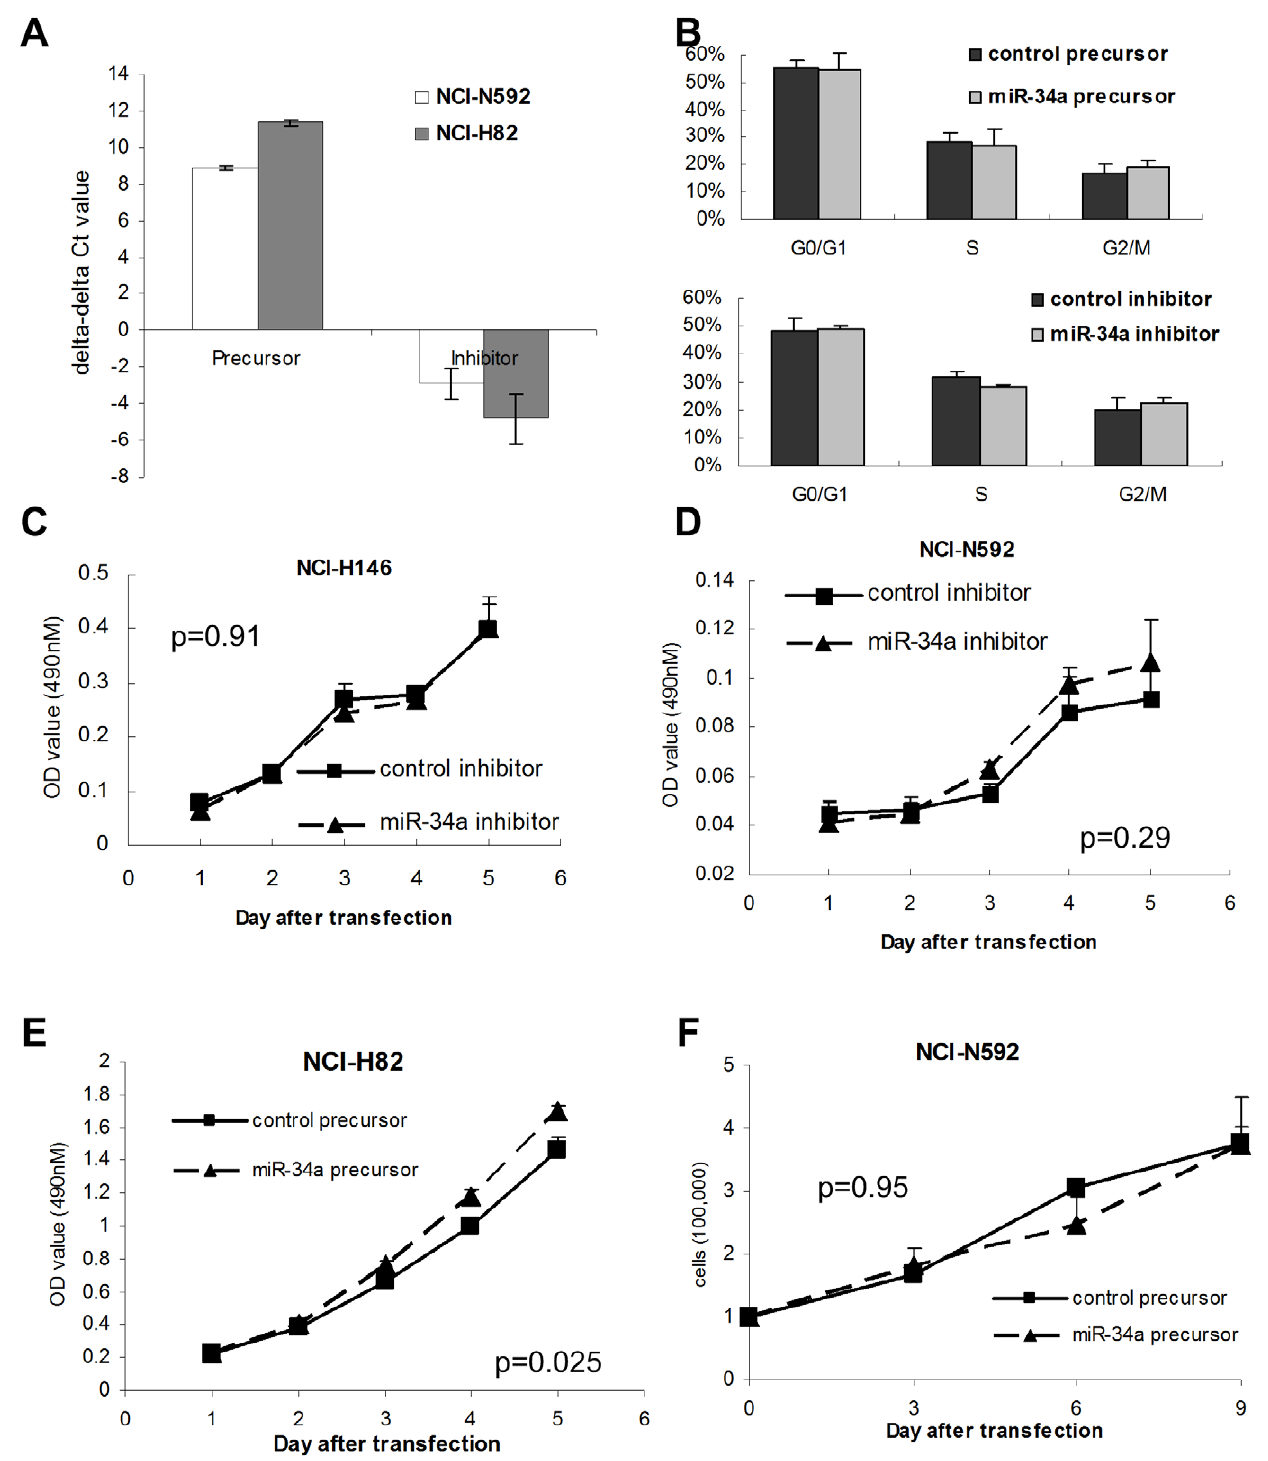
Figure 1. Ectopic overexpression or downregulation of miR34a in SCLC cell lines by microRNA precursor or inhibitor. (A) miR-34a expression in NCI-N592 cells and NCI-H82 cells transfected with miR-34a precursor or inhibitor. The delta-delta Ct value was calibrated to the delta Ct value of miR34a in cells transfected with control miR precursor or inhibitor, respectively. (B) Cell cycle distribution of NCI-H82 cell transfected with control miR precursor, miR-34a precursor, control miR inhibitor, and miR-34a inhibitor. (C and D) Cell growth assay of NCI-H146 (C) and NCI-N592 (D) cells transfected with miR-34a inhibitor or control miR inhibitor. (E) Cell growth assay of NCI-H82 cells transfected with miR-34a precursor or control miR precursor. (F) Cell viability of NCI-N592 cells after repetitive transfection of control miR precursor or miR-34a precursor. Cells were counted and transfected again every three days. Error bars indicate standard deviation. p-values were calculated according to cell viability 5 days after transfection with the exception of microRNA precursor in NCI-N592 cell, which was calculated according to the number of cells counted 9 days after the first transfection.